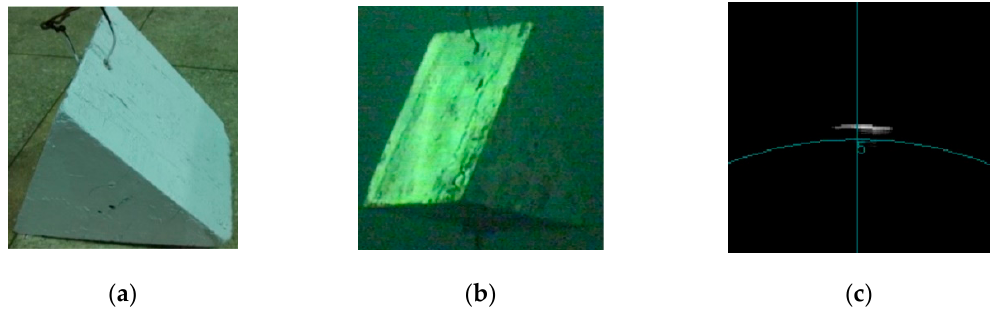
Figure 2. Image of target under different conditions: optical image gained in: ( a ) air and ( b ) water. ( c ) Acoustic image gained in water.